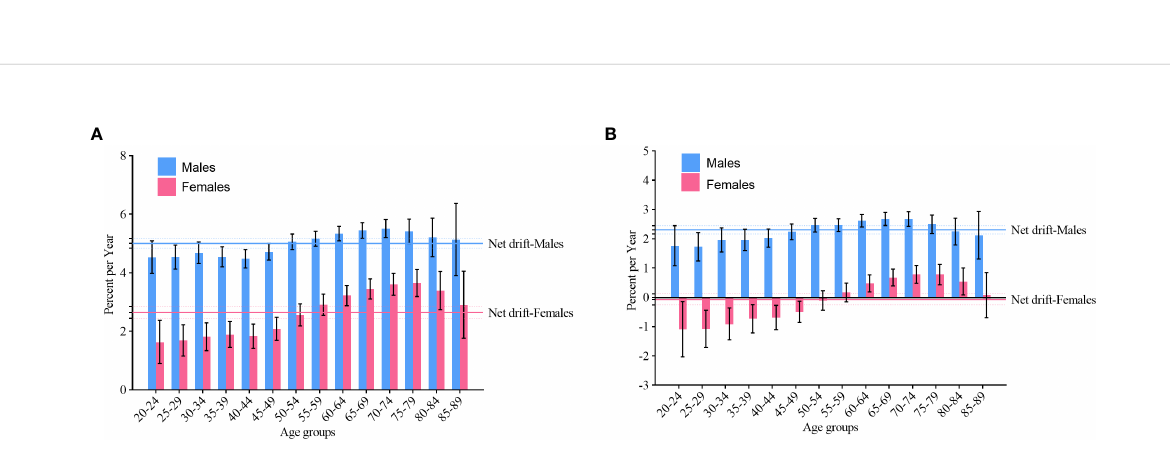
local drift value was 2.7 (95% CI: 2.5, 2.9) in males aged 65-69 years and 0.8 (95% CI: 0.5, 1.1) in females aged 70-74 years. The local drift value of NHL mortality among females aged 20-50 years was less than 0 (p< 0.05).